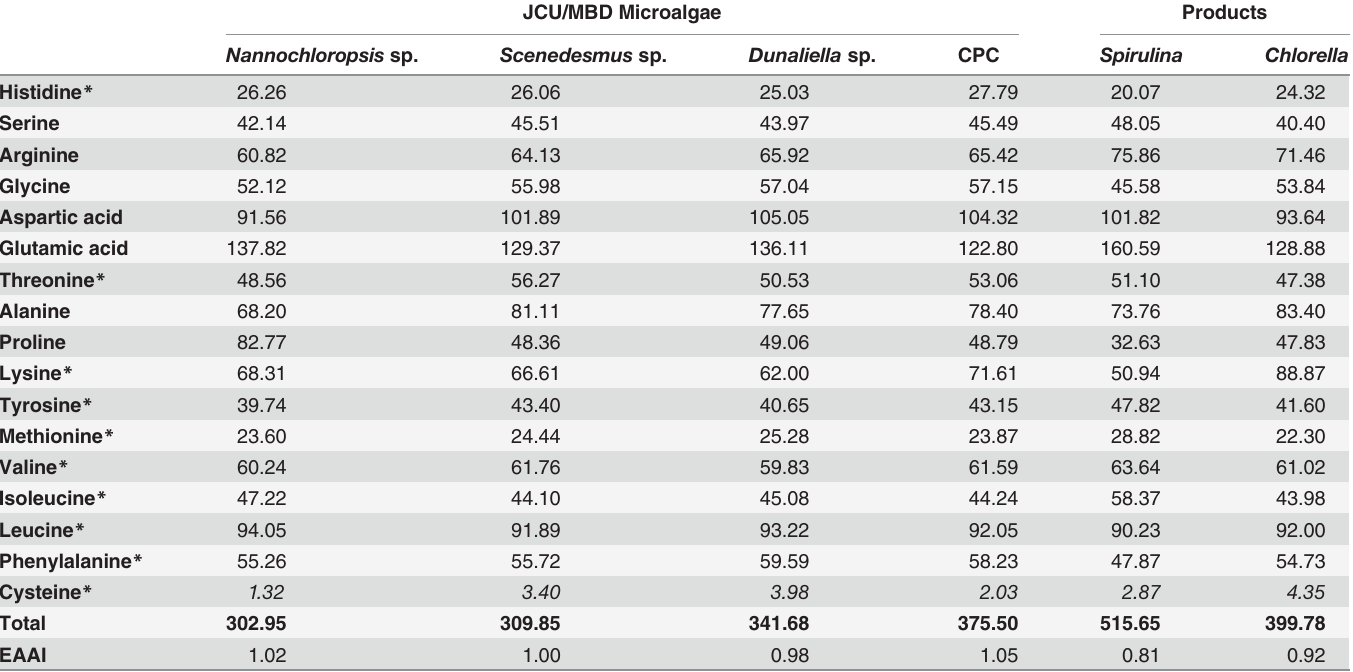
Table 5. Amino acid residue content (mg g -1 dry weight) and essential amino acid index (EAAI) value of James Cook University/MBD Energy (JCU/MBD) microalgae and commercial microalgae